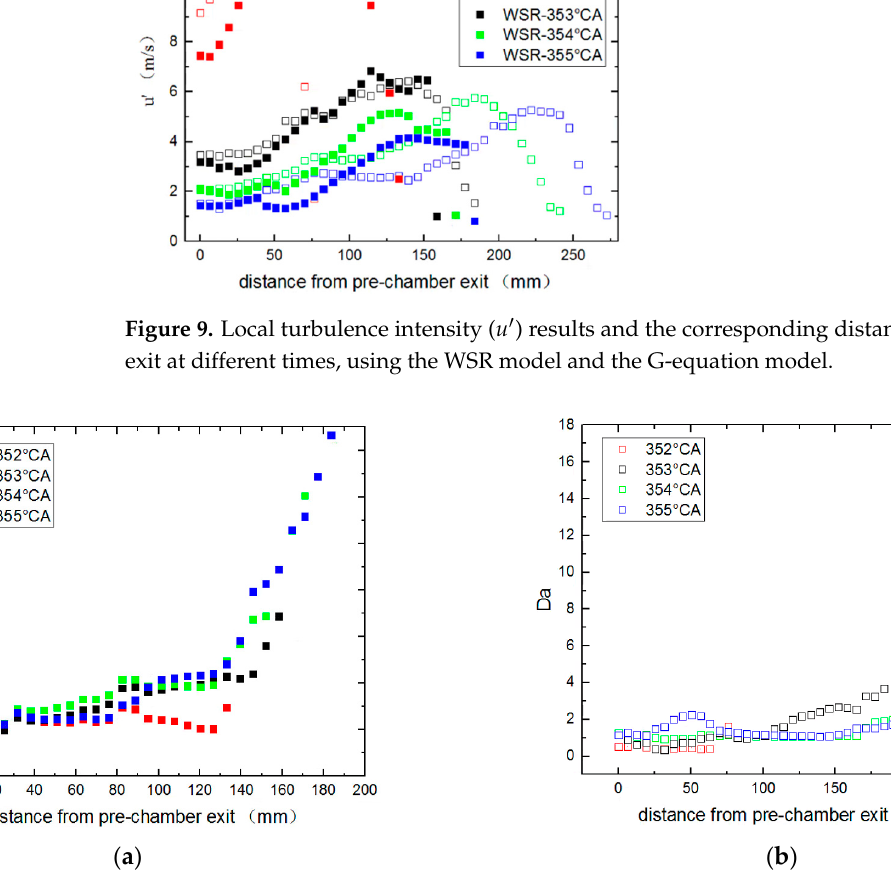
( b ) Figure 11. The discrete points of jet flame in the Borghi–Peters diagram [27] at different times, us- ing ( a ) the WSR model and ( b ) the G-equation model. In order to further understand the flame structure, the RXR distribution on the clip plane along the jet direction for case 3 at 353.8 °CA ( T m in case 5) is shown in Figure 12, and the corresponding formation and production rate of methyl are shown in Figure 13. As can be seen, similar RXR occurs inside the pre-chamber and jet flame core near the exit, which suggests the burning mixture in the pre-chamber is pushed into the main chamber along with the jet, and the reaction status is not changed much during this process. In addition, the reaction at the periphery of the jet is mainly participated by methyl, which is mainly from the premixed CH 4 reaction according to the analysis in Figure 13. This justifies the use of G-equation to describe flame propagation in premixed CH 4 in the mapping approach.